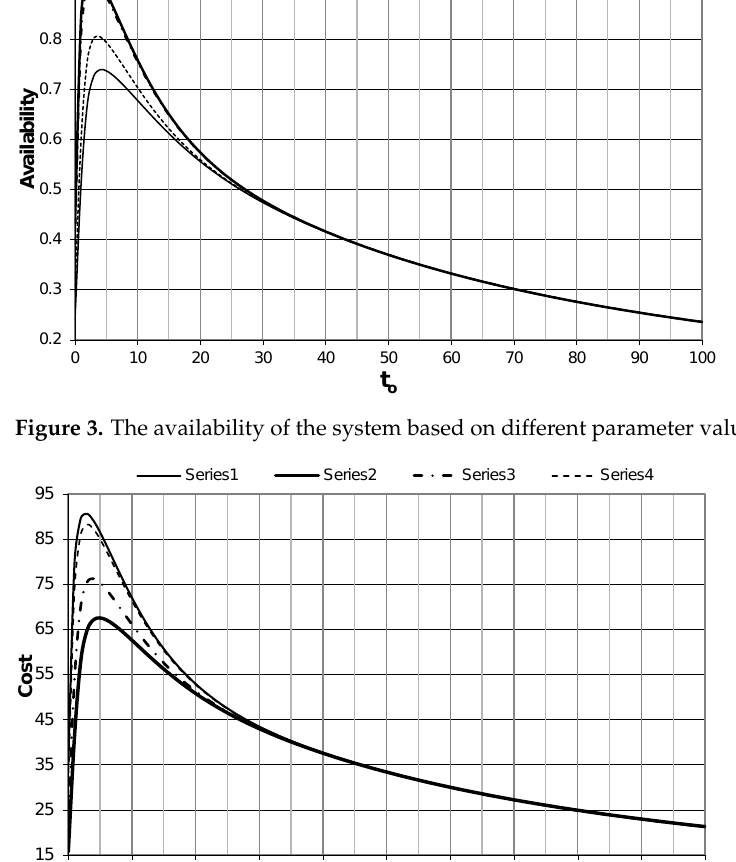
Figure 4. The cost function based on different parameter